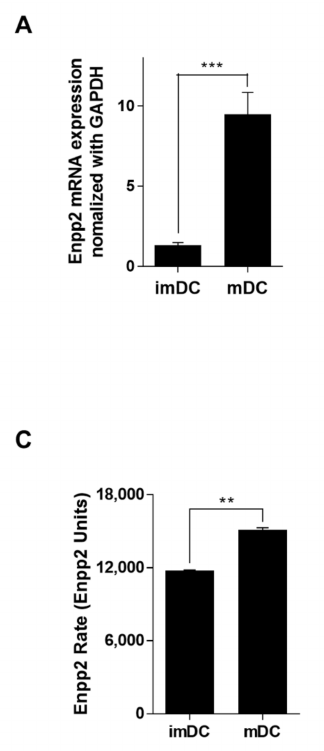
Figure 1. mDCs secrete high levels of Enpp2. ( A ) DC subsets were cultured and Enpp2 expression measured by qRT-PCR. Values were normalized to GAPDH expression. Data are expressed as the mean ± SEM ( n = 5 independent DC preparations) of duplicate experiments. ( B ) Secreted Enpp2 protein in concentrated (20-fold) conditioned low serum medium from DCs was detected by Western blotting. The bar graphs show data derived from densitometric analysis of western blot data. Values are expressed as the mean ± SEM ( n = 3 independent experiments). ( C ) A fluorescence assay of Enpp2 activity. Enzyme activity in conditioned medium was measured for over 2 h. The bar graph shows the Enpp2 activity rates, expressed as the mean ± SEM ( n = 3 independent DC preparations). ** p < 0.01 and *** p < 0.001, compared with immature